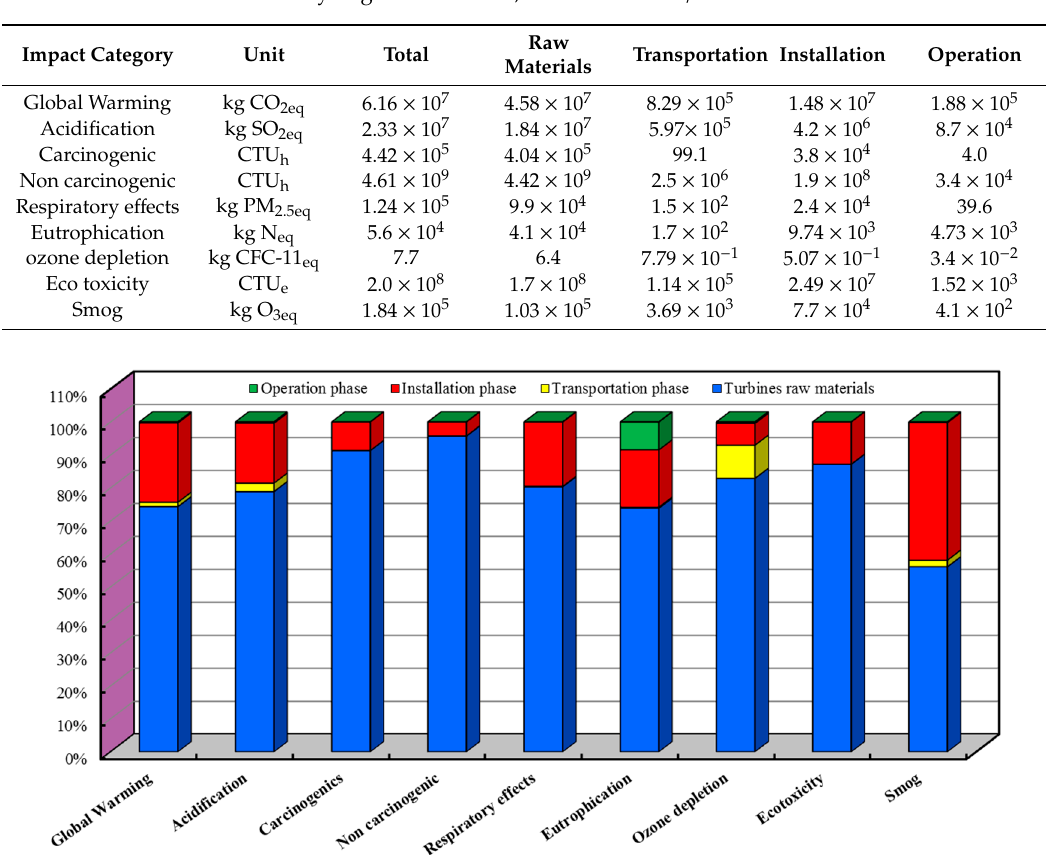
Figure 4. The environmental impacts for all phases.